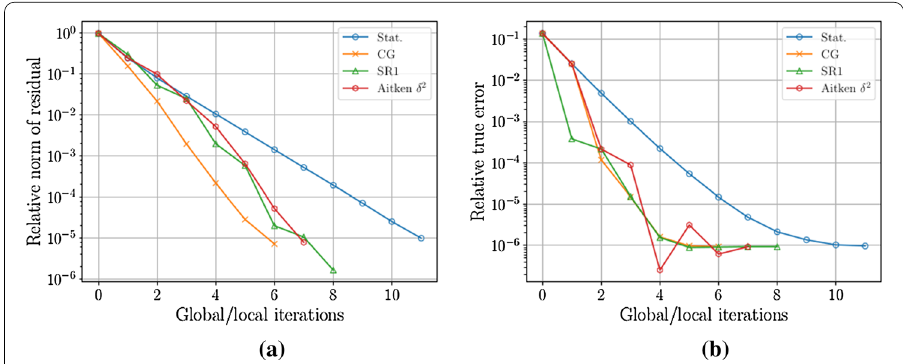
Fig. 4 Convergence in the full linear case. a Evolution of the residual. b Mises stress error wrt Reference on the loaded element